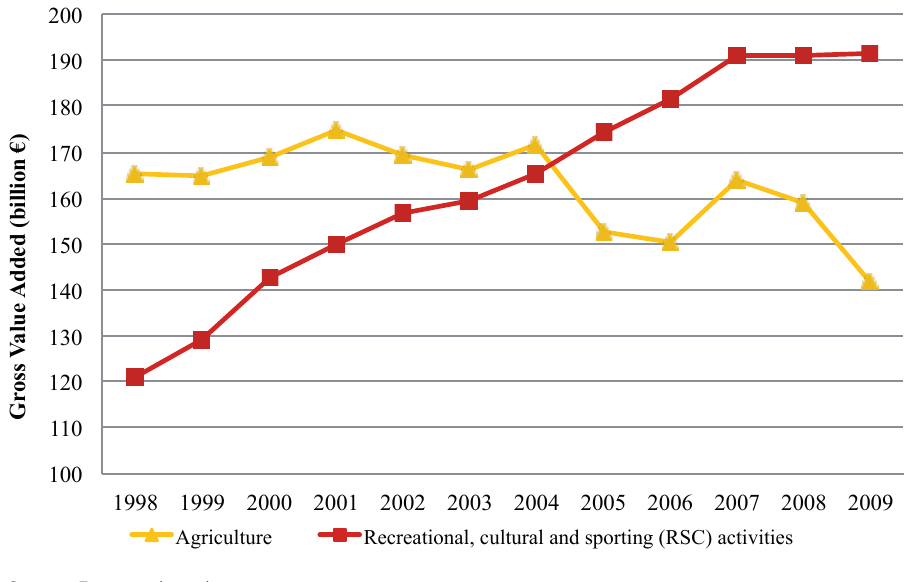
Figure 4. Gross value added (GVA) of the agricultural sector vs. the recreational, cultural and sports (RCS) sector in the EU-15 (billion €;